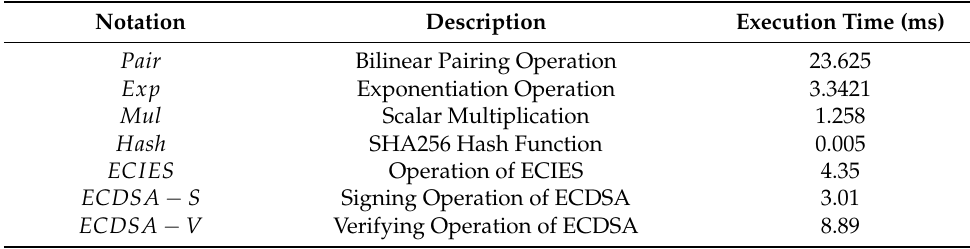
Table 1. Execution Time of Cryptographic